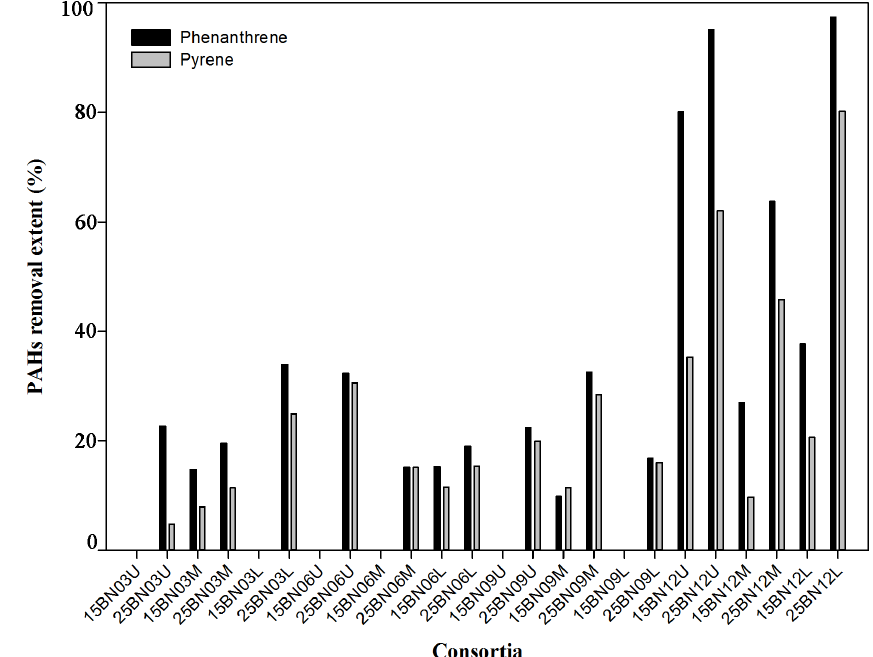
Figure 4. PAH-removal extent of the consortia that were enriched from the sediments of the Arctic Ocean. The consortia were grown with a mixture of PAHs (naphthalene, phenanthrene and pyrene) as the sole carbon and energy source. PAHs were quantified using GC-MS after pretreatments. Naphthalene was not included due to an error caused by its high volatility. Consortia names with prefixes “15” or “25” indicate that they were enriched at 15 or 25 ◦ C,